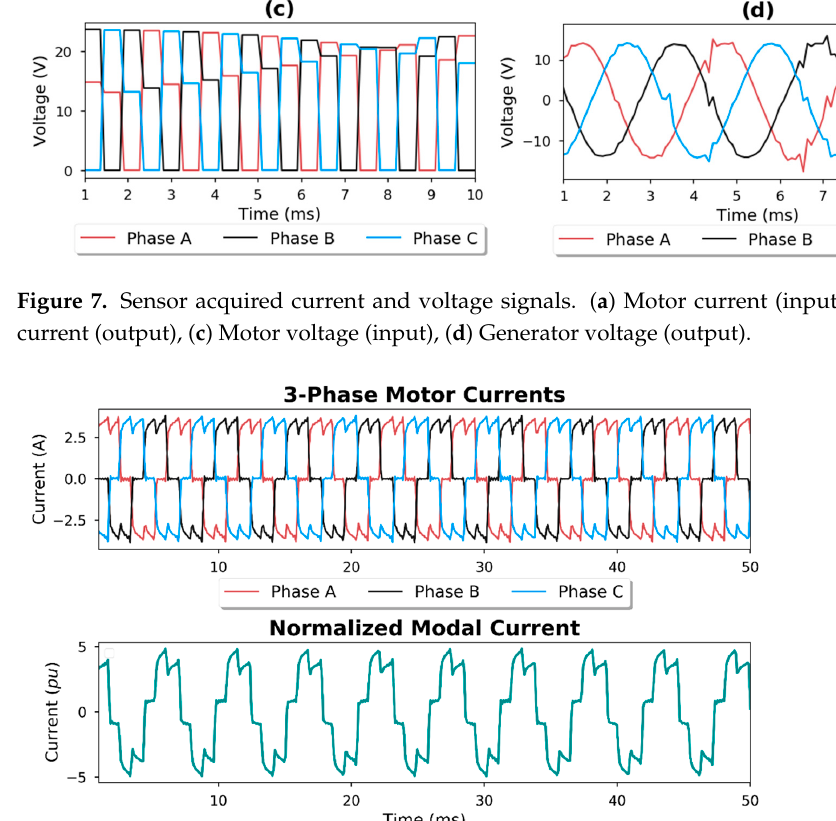
Figure 9. Third harmonic (H3) analysis of the motor currents in healthy state (row A ), ITF fault state (row B ), WSC fault state (row C ), hybrid fault state (row D ). Column X is the sensor acquired time series signal, column Y is the FFT transfor- mation, column Z is the time-frequency representation using CWT. Table 3. NMCSA results. NMC Parameters